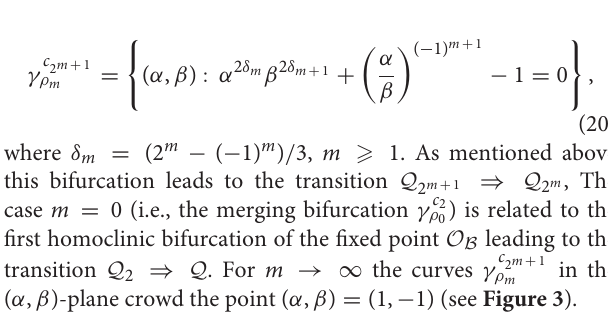
FIGURE 2 | Bifurcation structure of the ( µ L , µ R )-parameter plane of f . (A) Regular dynamics: colors correspond to periods of related cycles, while gray hatched areas are associated with diverging orbits. (B) Chaotic dynamics: periodicity regions are shown in gray, while chaoticity regions related to chaotic attractors with different number of intervals are shown with different colors. Parameters: a L = 0.5, a R = 1.3, d L = 0, d R = 0.3.